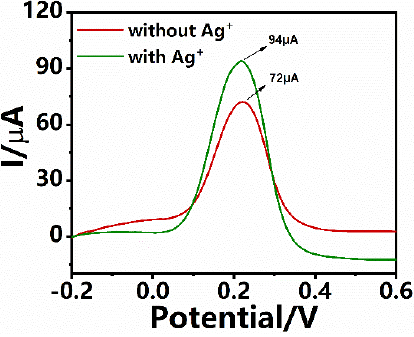
Figure 7. DPV current responses of the electrochemical sensor before and after treatment with Ag+ in 0.01M PBS (pH = 9) containing 4 mg mL –1 1-naphthalene sodium phosphate.